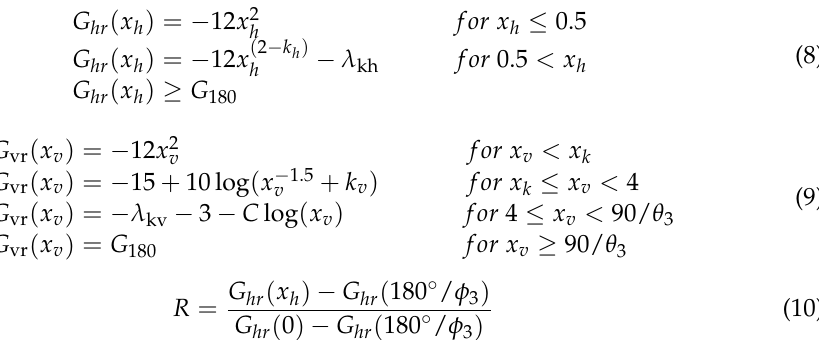
Figure 5. 2nd layer cell antenna pattern.